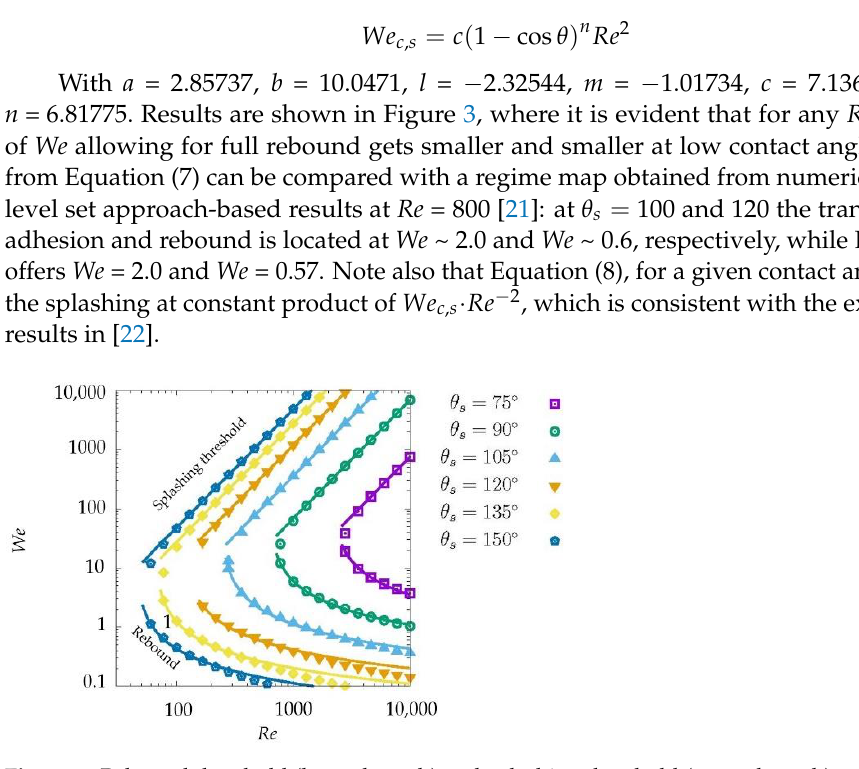
Figure 3. Rebound threshold (lower branch) and splashing threshold (upper branch) as a function of We, Re and wettability. Solid lines: correlations Equations (7) and (8). Symbols: computed values. For any given Re and contact angle rebound occurs if We falls between the two thresholds.